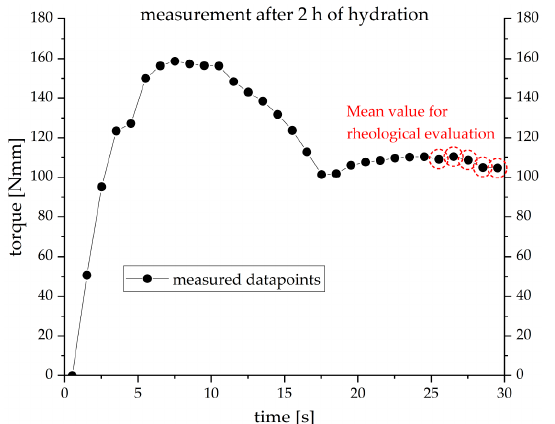
Figure 1. Exemplary result of a rheological measurement after two hours of hydration at a speed of 2 rpm at 20 °C (w/c = 0.36).